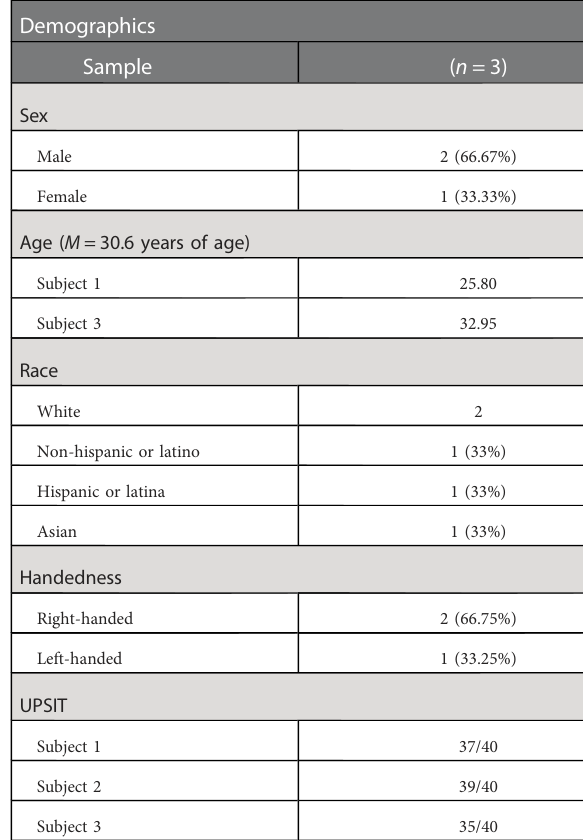
TABLE 1 Study participant